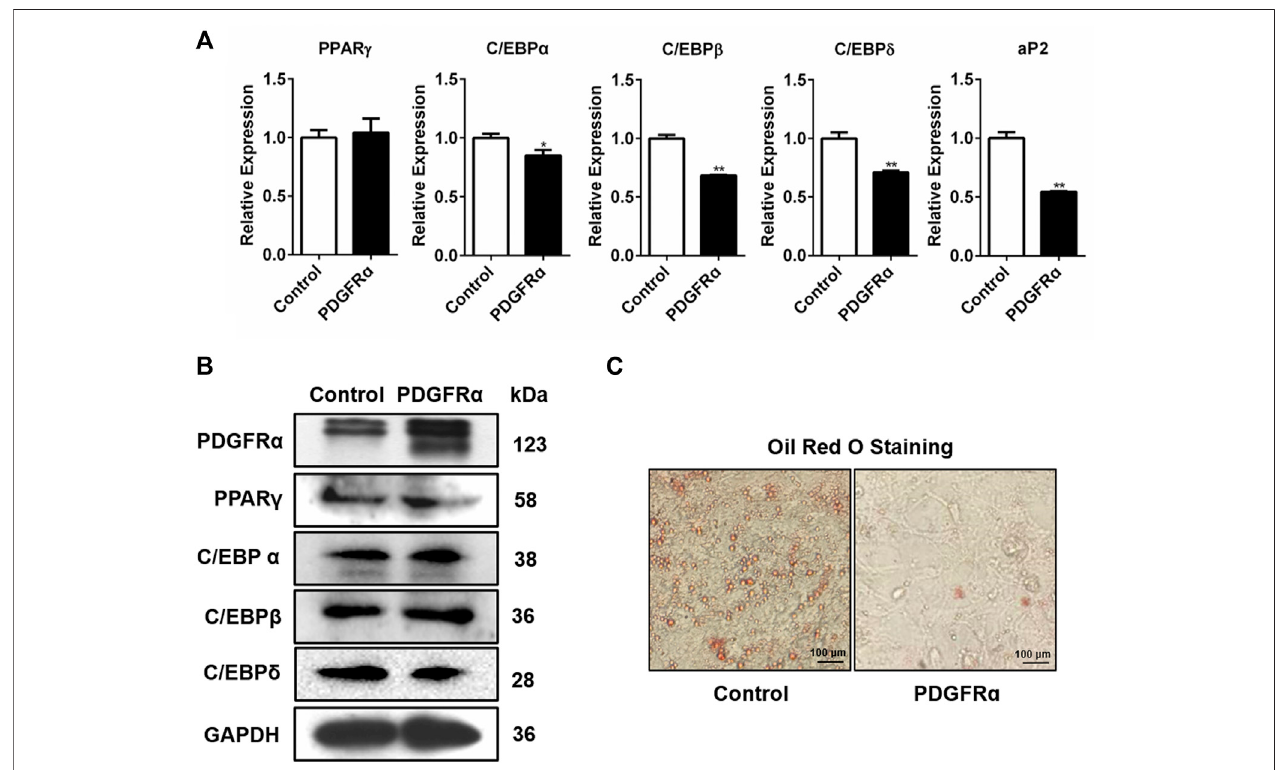
FIGURE 4 | In fl uence of PDGFR α on adipogenesis-linked gene expression and lipid droplet synthesis in 3T3-L1 cells. (A) qRT-PCR analysis of the expression of adipogenesis-associated genes after transfection with pEGFP-N1-PDGFR α (PDGFR α ) or control in 3T3-L1 cells. (B) Western blotting analysis of the expression of adipogenesis-associated transcription factors after transfection with pEGFP-N1-PDGFR α (PDGFR α ) or control in 3T3-L1 cells. (C) Illustrative images of oil red O after transient transfection with pEGFP-N1-PDGFR α (PDGFR α ) or control (100-fold magni fi cation) in 3T3-L1